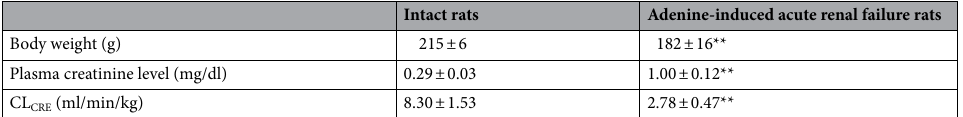
Table 1. Body weight of and renal functions in intact and adenine-induced acute renal failure rats. CL CRE : creatinine clearance. CL CRE is calculated using the following equation: CL CRE = [urine creatinine level (mg/ dl) × urine volume (ml/min)] / plasma creatinine level (mg/dl) / body weight (kg). Each value is presented as mean ± SD of six animals. ** P < 0.01, significantly different from the intact rats according to Student’s